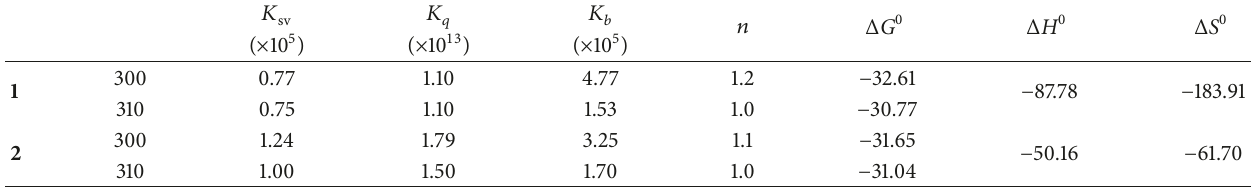
Table 1: Stern-Volmer quenching constant ( 𝐾 sv , L ⋅ mol −1 ), biomolecular quenching rate constant ( 𝐾 𝑞 , L ⋅ mol −1 ⋅ s −1 ), binding constant ( 𝐾 𝑏 , L ⋅ mol −1 ), the number of binding sites ( 𝑛 ), and Δ G 0 (KJ ⋅ mol −1 ), Δ H 0 (KJ ⋅ mol −1 ), and Δ S 0 (J ⋅ mol −1 ⋅ K) values for the complex-BSA system at different temperatures.